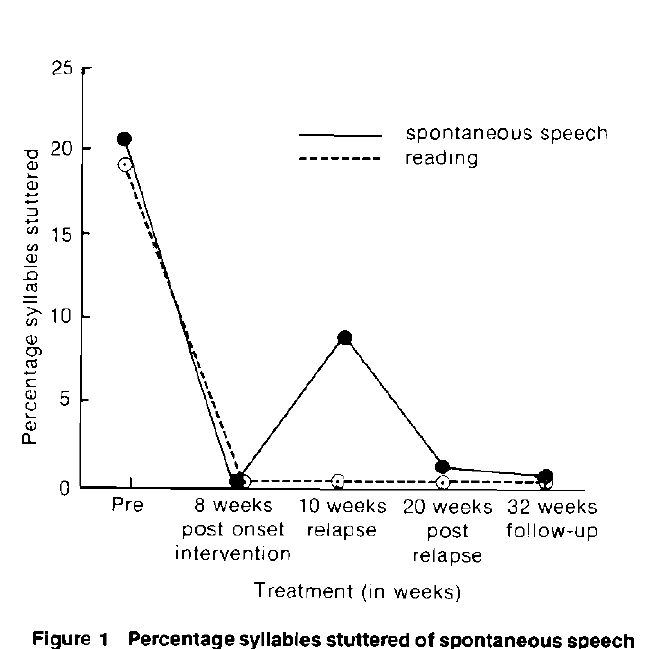
Figure 1 Percentage syllables stuttered of spontaneous speech and reading samples over the 8 month period of therapy.